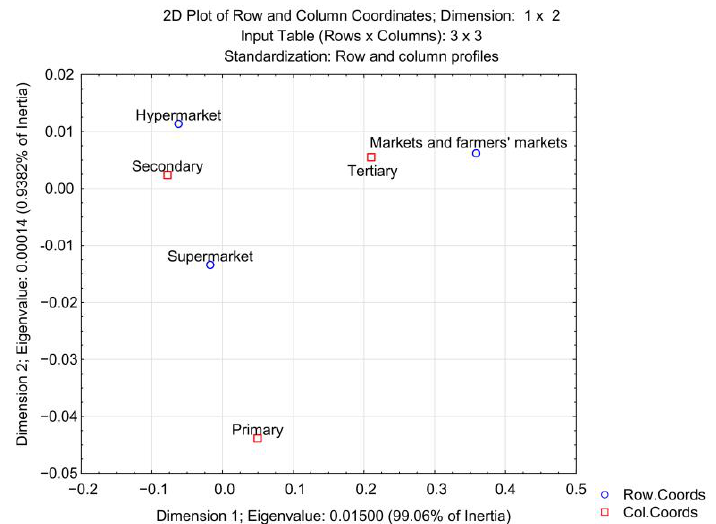
Figure 10. Place of purchase & age. Source: authors.